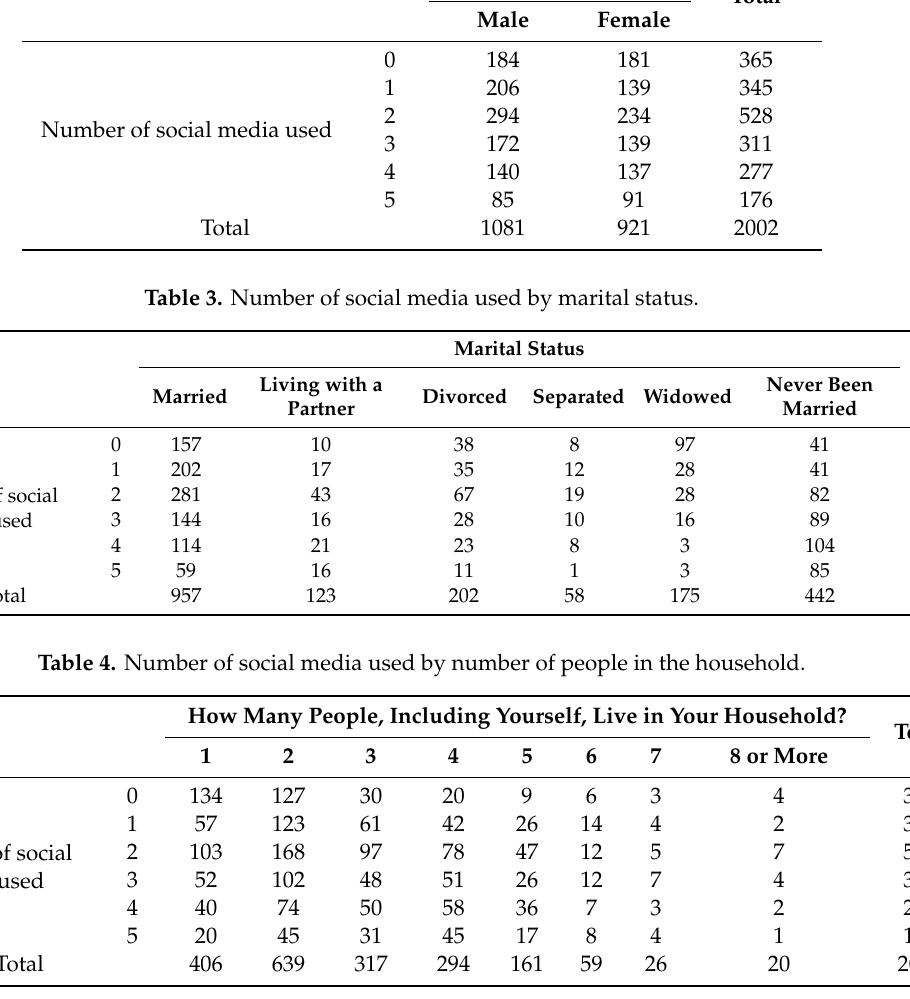
Table 2. Number of social media used by gender.